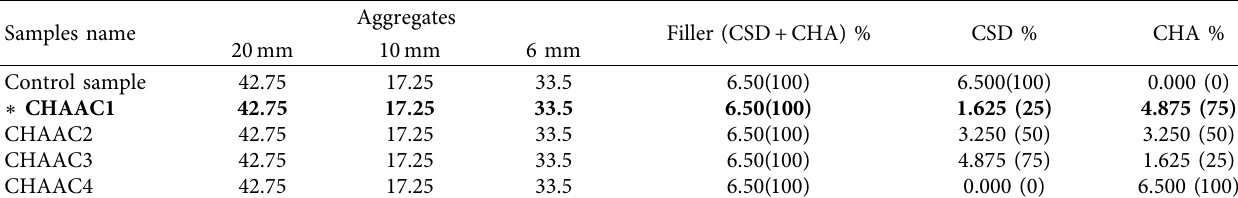
Table 13: Asphalt concrete mixtures prepared by using different filler rates for 6.5%